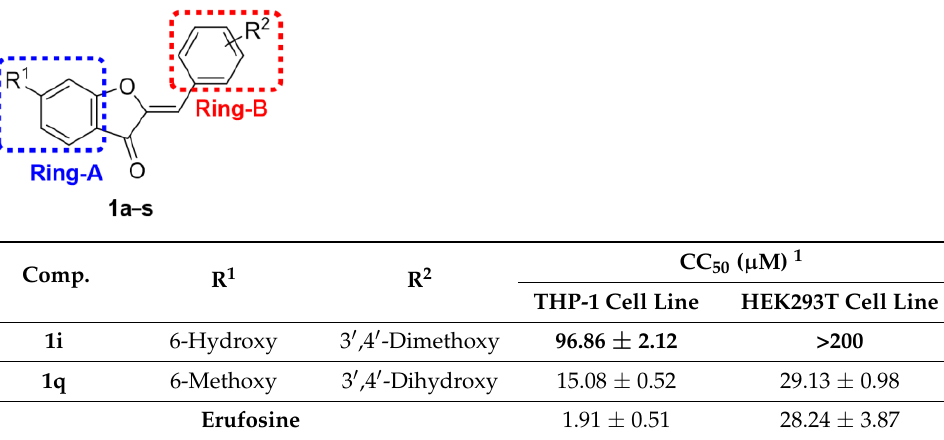
Table 2. Antileishmanial activities of sulfuretin analogs ( 1a − s ), sulfuretin and a standard al- Table 3. Cytotoxicity and cell viability evaluation for the most potential sulfuretin analogs ( 1i & 1q ) kylphospholipid-based and the standard alkylphospholipid-based drug.